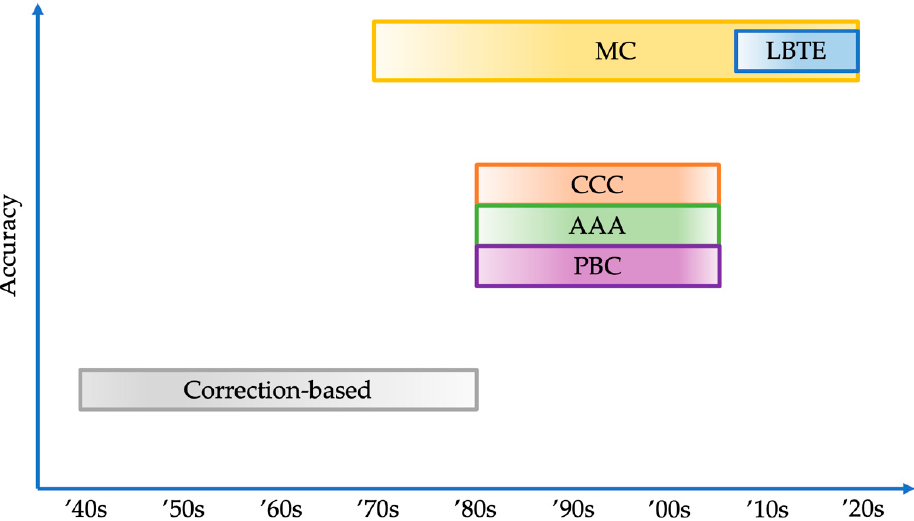
Figure 1. Historical evolution of dose calculation engines and their relative accuracy. Abbreviations: PBC: pencil beam convolution, AAA: analytical anisotropic algorithm, CCC: collapsed cone convolution, MC: Monte Carlo, LBTE: linear Boltzmann transport equations.